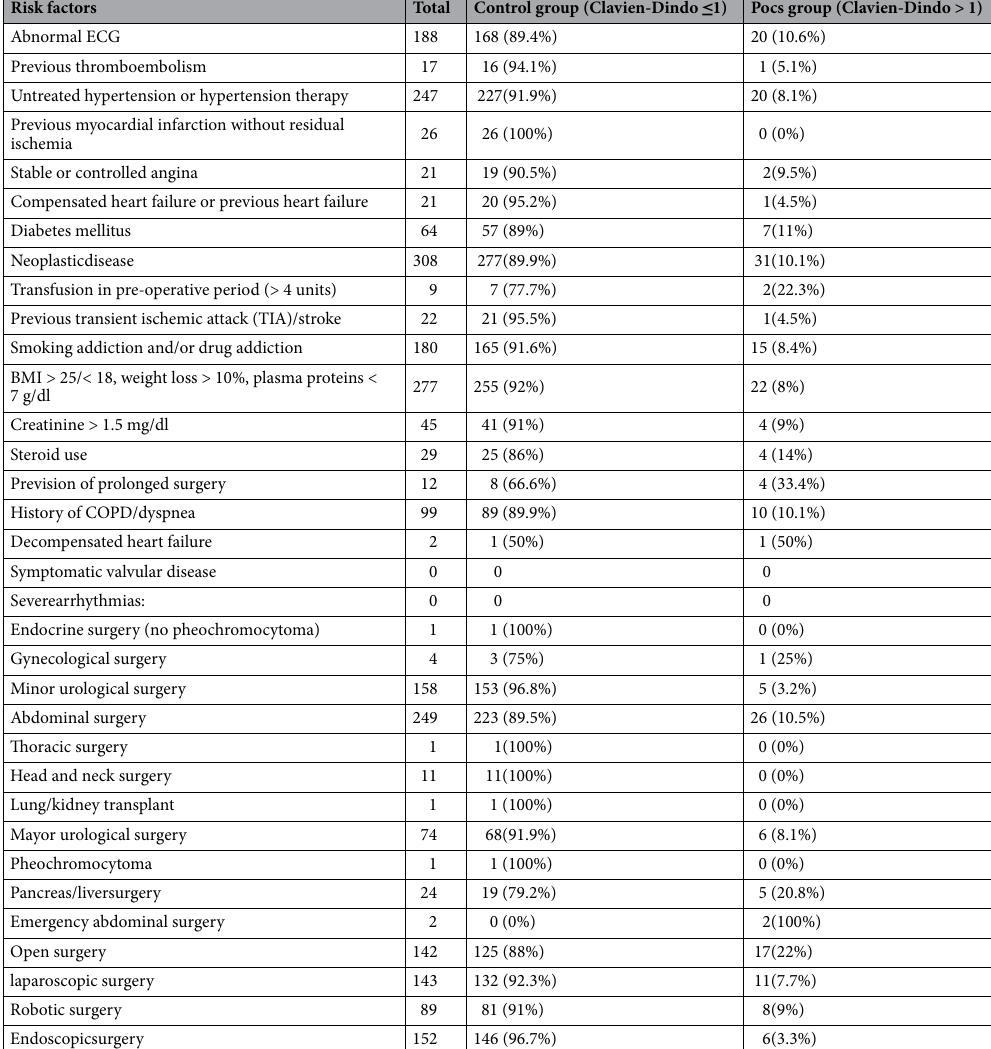
Table 2. Distribution of risk factors in the control group and the Pocs group. For layout reasons, some risk factors descriptions have been abbreviated with respect to Table 1.